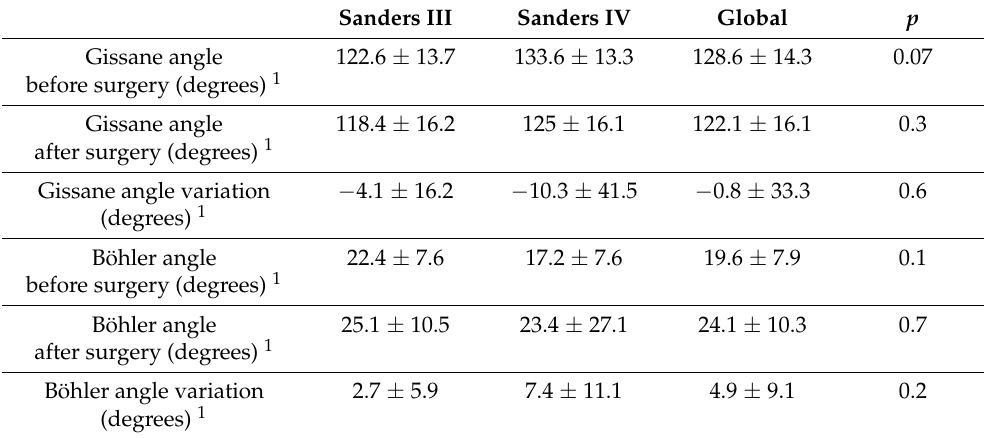
Table 2. Radiographic characteristics.